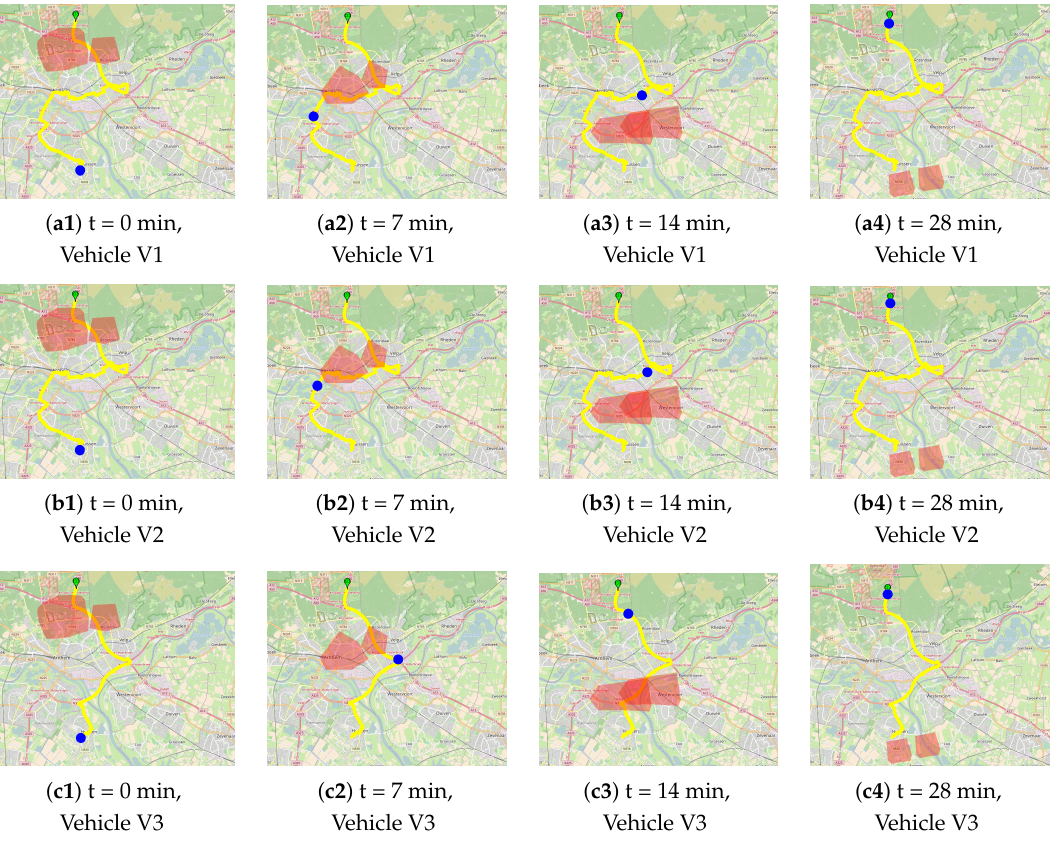
Figure 9. The calculated routes for the three vehicles (V1, V2 and V3) in scenario 2, starting from the blue point to the green